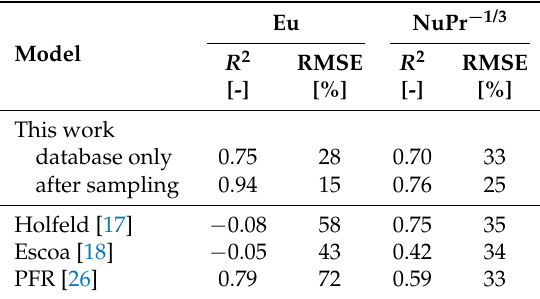
Table 4. Accuracy on validation dataset, computed from Latin hypercube sample of design space (30 CFD